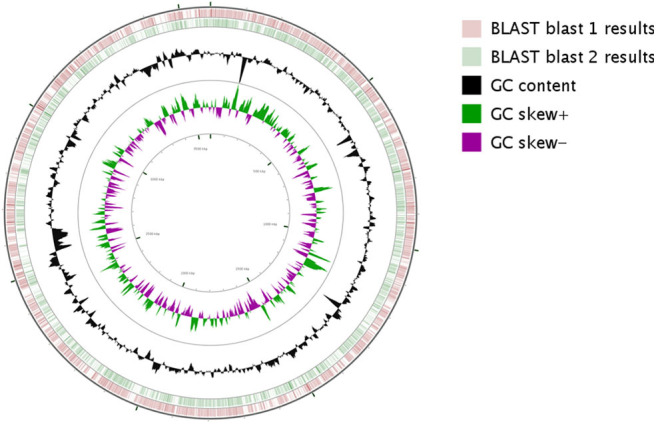
Circular representation of M. metallidurans TL13 genome generated by CG viewer. The innermost rings depict GC content (Black) and GC Skew (purple/green) followed by concentric rings of query sequences colored according to BLAST identity. The outermost rings depict genomes of the following microbes M. enclense NIO-1002 (pink) and M. hominis TPW29 (green).